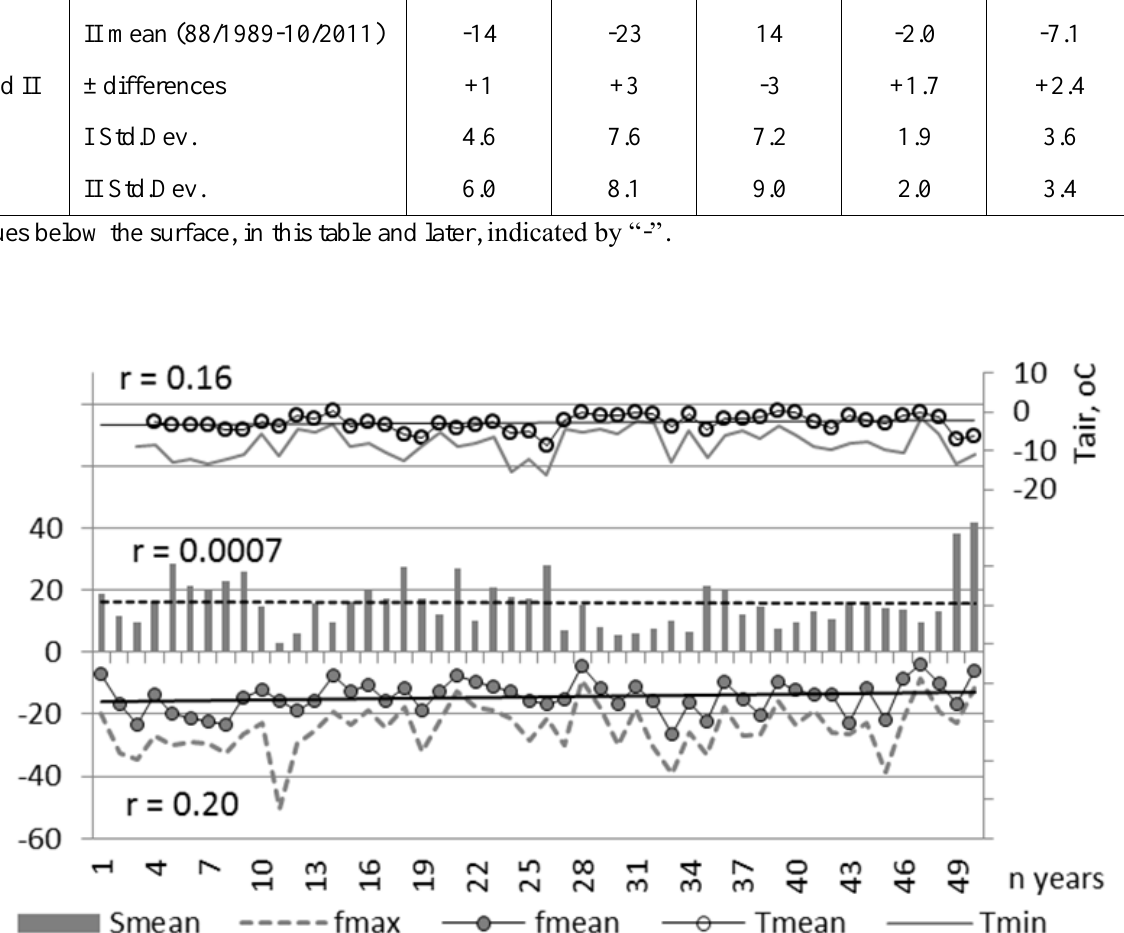
) and air temperature (T mean